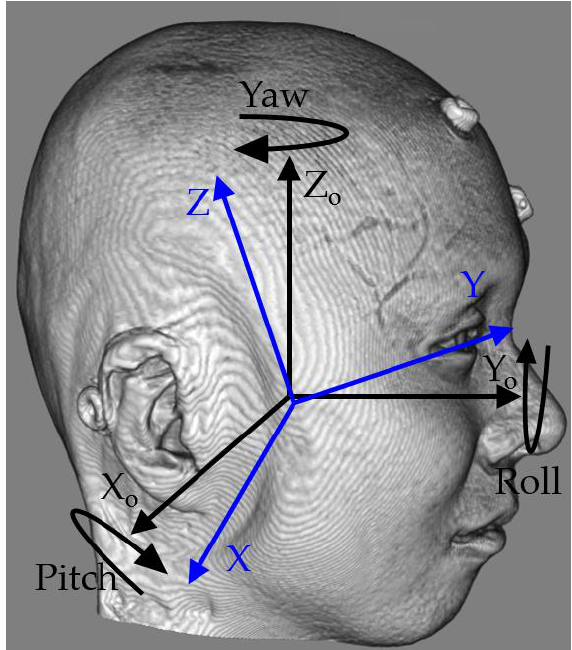
Figure 1. An ideal coordinate system X o Y o Z o (black) versus an imaging coordinate system XYZ (blue).